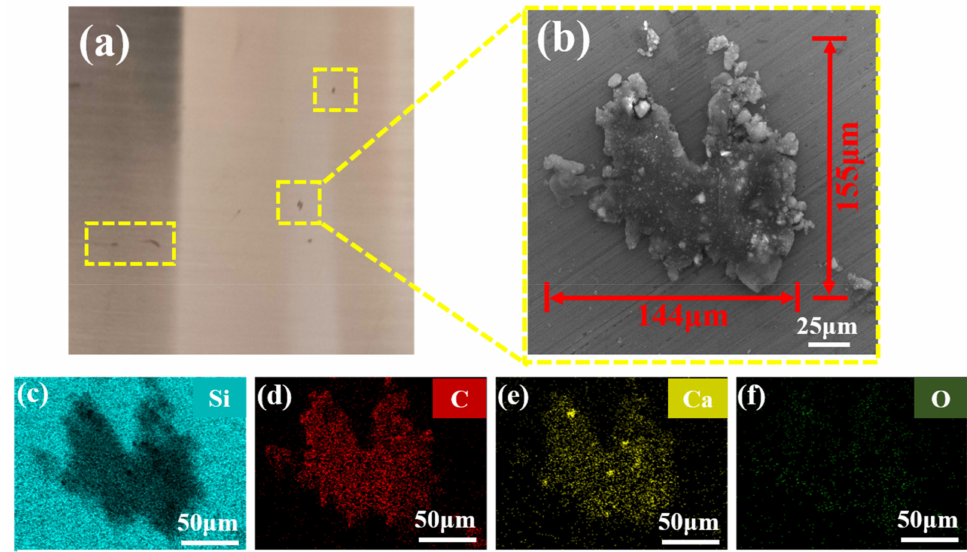
Figure 1. ( a ) Photograph of white-spot-stained silicon wafers, ( b ) SEM image of white-spot-stained silicon wafers, ( c ) elemental distribution of Si, ( d ) C, ( e ) Ca, ( f ) and